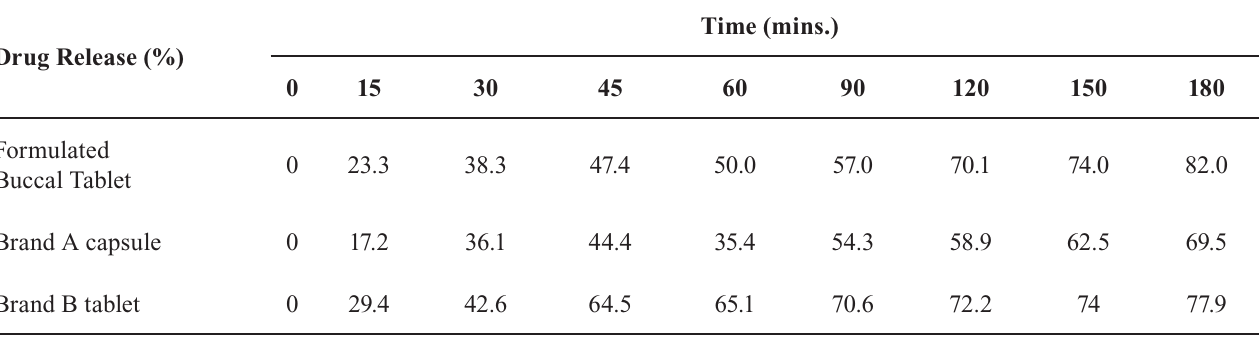
TABLE IV - Summary drug release of 250 mg mefenamic acid products available in market and 250 mg of the formulated mucoadhesive buccal tablet